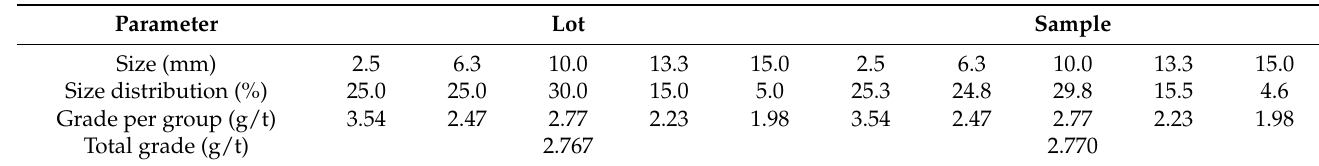
Table 8. Comparison between both grades lot x sample.